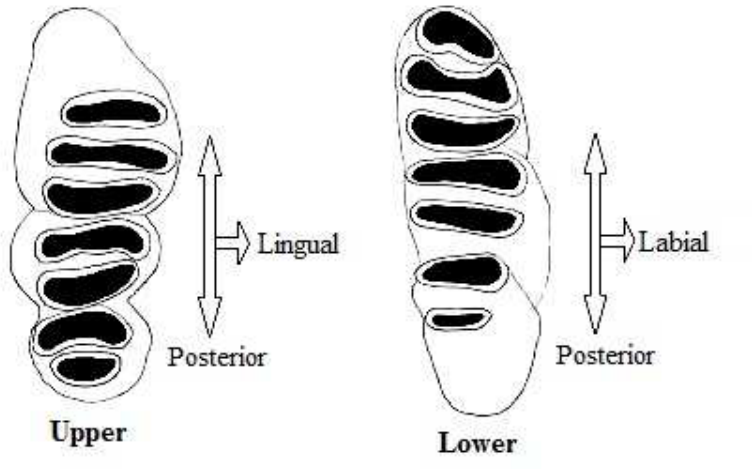
FIGURE 9 : Teeth rows in Nesokia